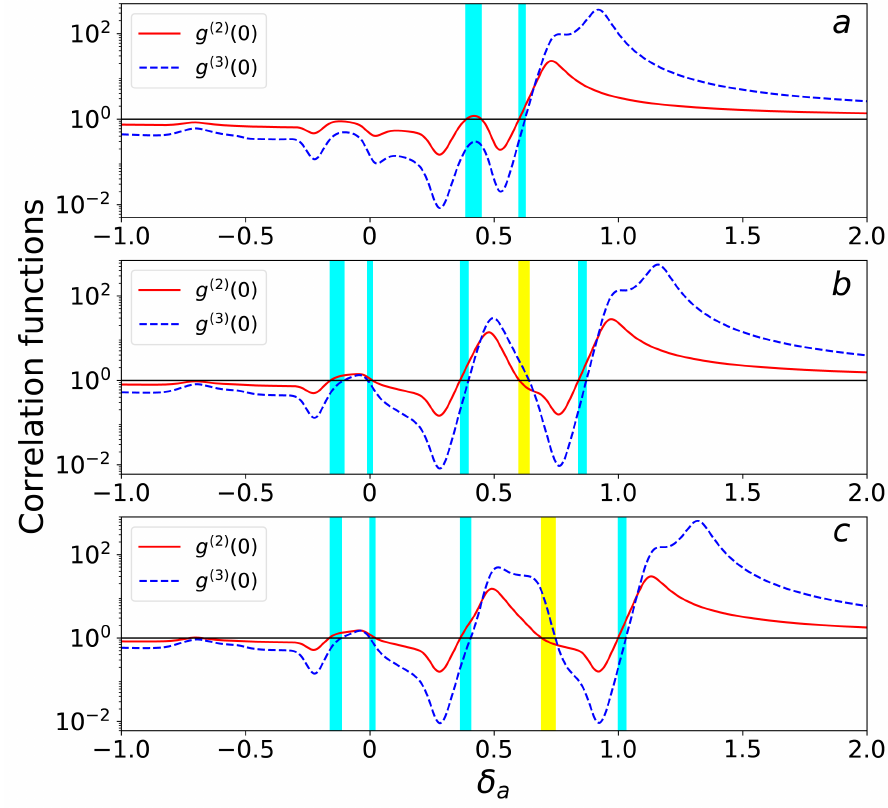
Figure 6. The equal-time SOC function g ( 2 ) ( 0 ) and TOC function g ( 3 ) ( 0 ) of the cavity field versus the driving detuning δ a for various values of the impurity–BEC coupling strength: ( a ) λ iB = 0.5, ( b ) λ iB = 0.8, and ( c ) λ iB = 1. Other parameters are C e = C g = √ 1, λ iC = 0.08, λ CB = 2/2, η = 0.01, γ c = 0.1 in units of Ω b